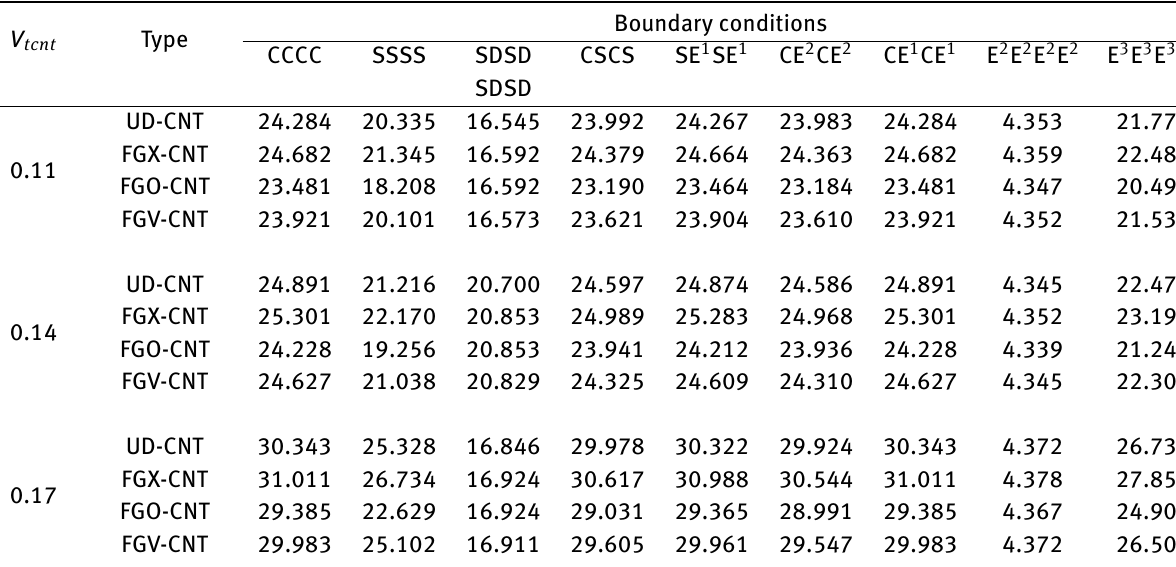
Table 6: Fundamental frequency parameters Ω for FG-CNT reinforced composite annular sector plates with different boundary